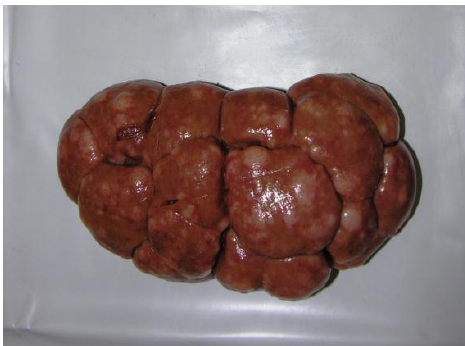
Figure 9: Microscopic view of the kidney illustrated in figure 8. Marked interstitial nephritis is apparent as indicated by the extensive infiltration of mononuclear inflammatory cells (mainly lymphocytes) within the interstitial tissue. H and E stain, X